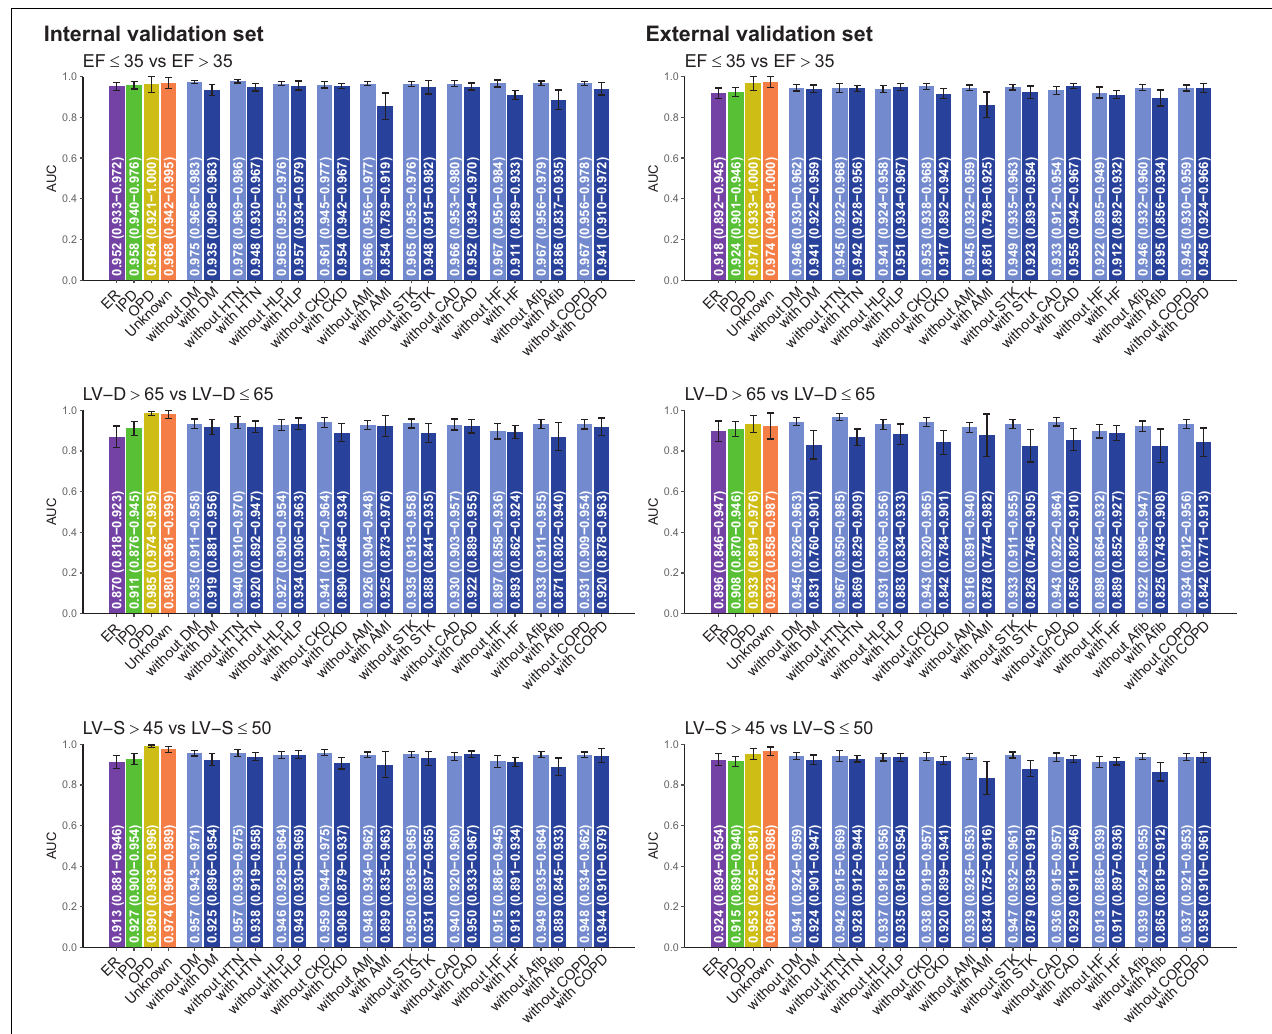
FIGURE 4 | Stratified analysis for model performance for predicting electrocardiogram-based ejection fraction (ECG-EF), left ventricular end-diastolic diameter (LV-D), and left ventricular end-systolic diameter (LV-S). The analyses were stratified by the disease histories or data source. The AUC and 95% CI s were presented based on LV EFs and diameters. ER, Emergency room; IPD, inpatient department; OPD, outpatient department; DM, diabetes mellitus; HTN, hypertension; HLP, hyperlipidemia; CKD, chronic kidney disease; AMI, acute myocardial infarction; STK, stroke; CAD, coronary artery disease; HF, heart failure; Afib, atrial fibrillation; COPD, chronic obstructive pulmonary disease